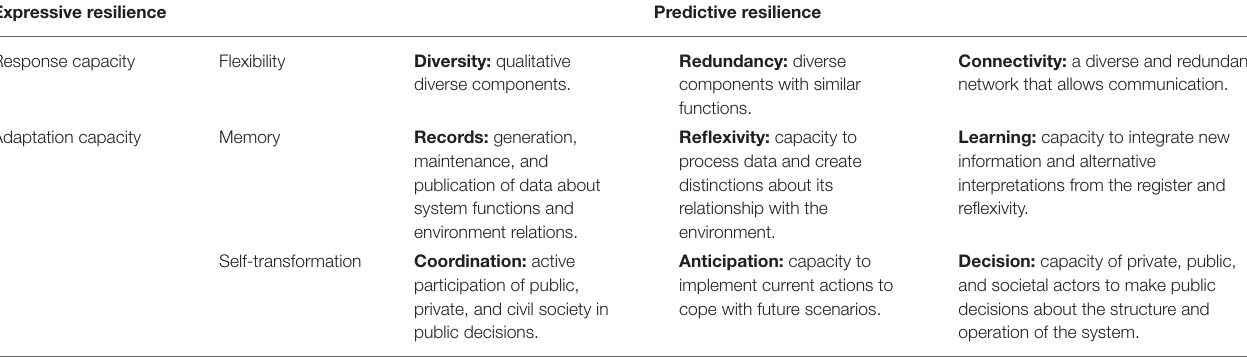
TABLE 1 | Resilience in sociotechnical